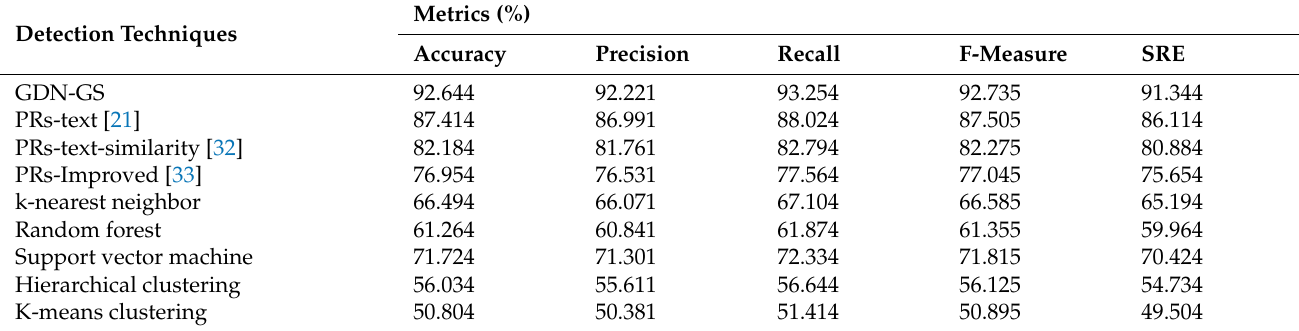
Table 5. Comparative analysis with DupPR-basic